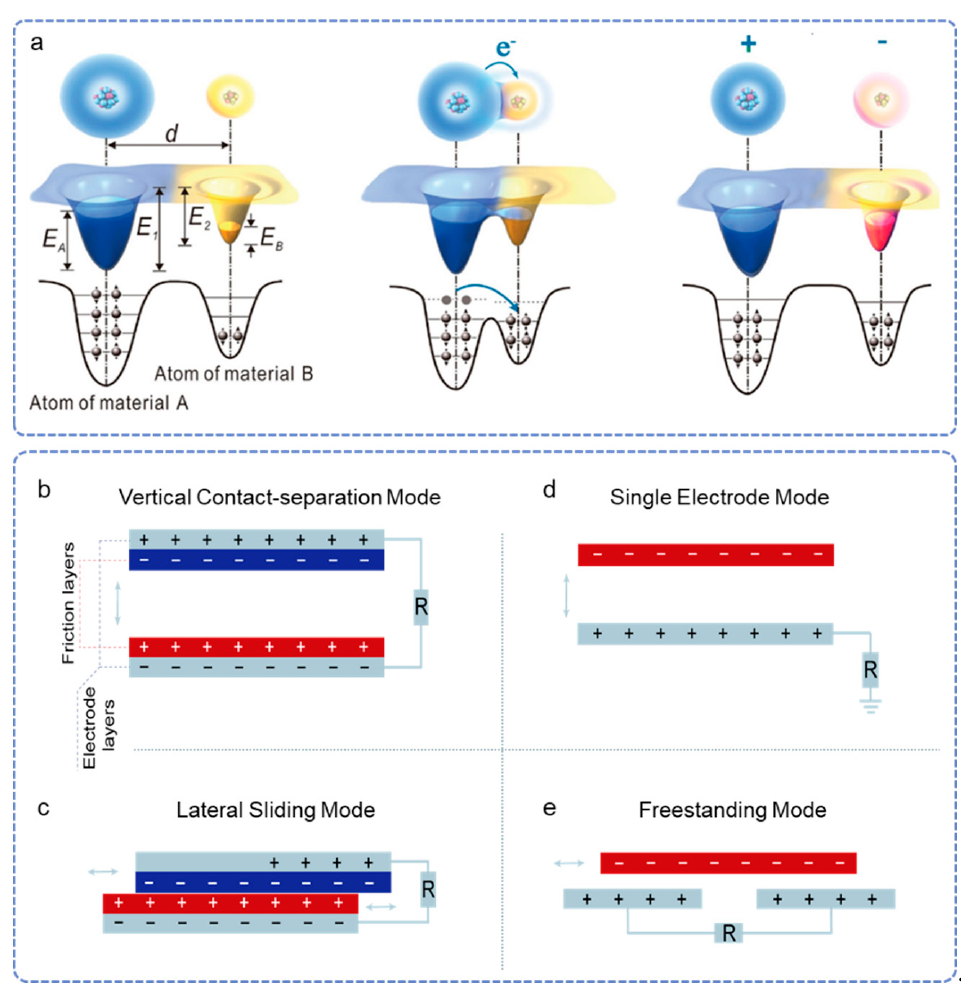
Figure 2. The working principle of triboelectric nanogenerators (TENGs). ( a ) Contact-electrification mechanism explained by electron cloud potential well model. Reprinted with permission from Refer- ence [118]. Copyright 2018 John Wiley & Sons. Four modes of TENGs, including ( b ) vertical contact- separation mode, ( c ) single electrode mode, ( d ) lateral sliding mode, and ( e ) freestanding